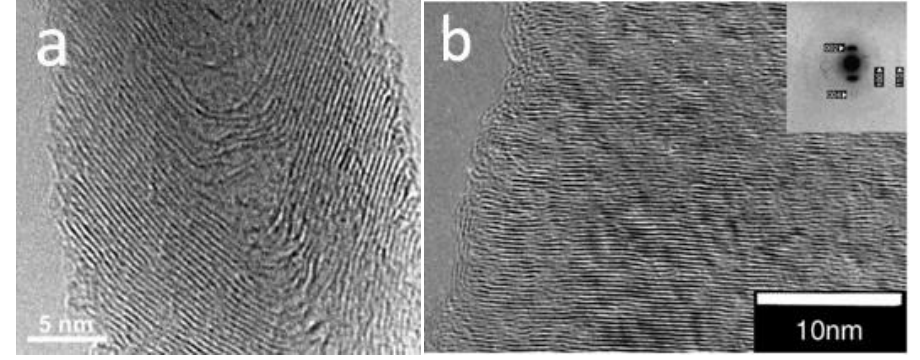
Figure 5. High resolution transmission electron microscope (HRTEM) image of ( a ) cup-stacked CNF and ( b ) platelet CNF